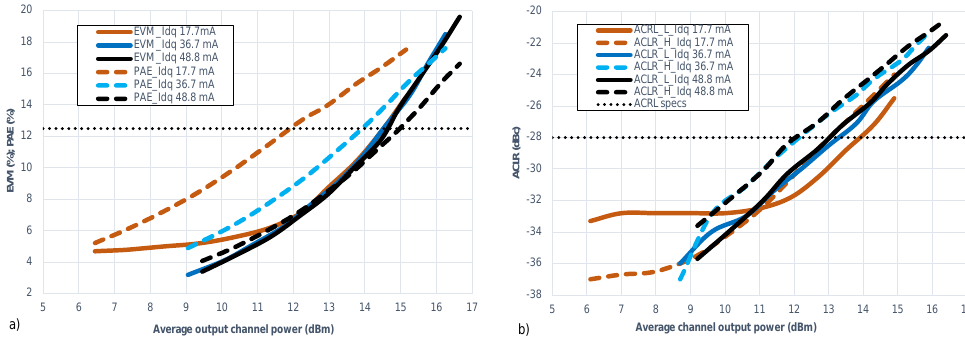
Figure 12. ( a ) EVM, PAE and ( b ) ACLR as a function of average output channel power at three different bias currents at 24 GHz using 100 MHz 16-QAM 3GPP/NR2 OFDM